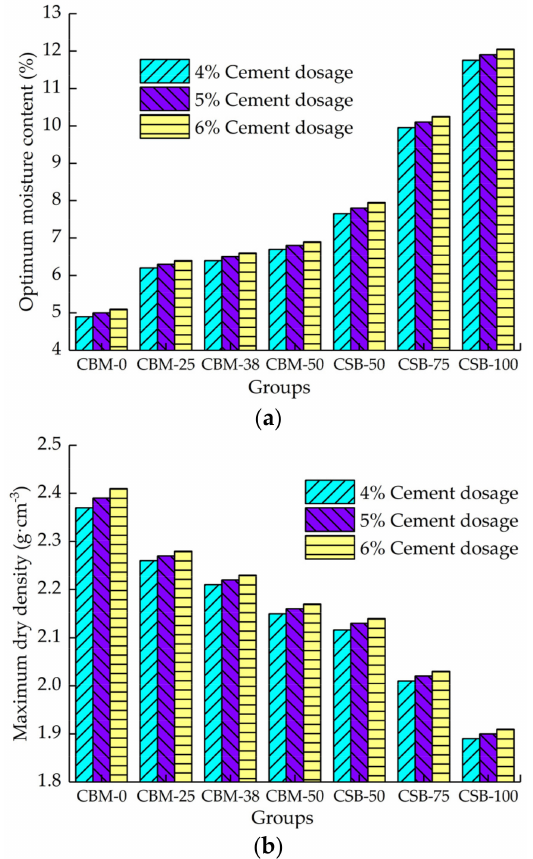
Figure 7. Test results of compaction test. ( a ) Optimum moisture content. ( b ) Maximum dry